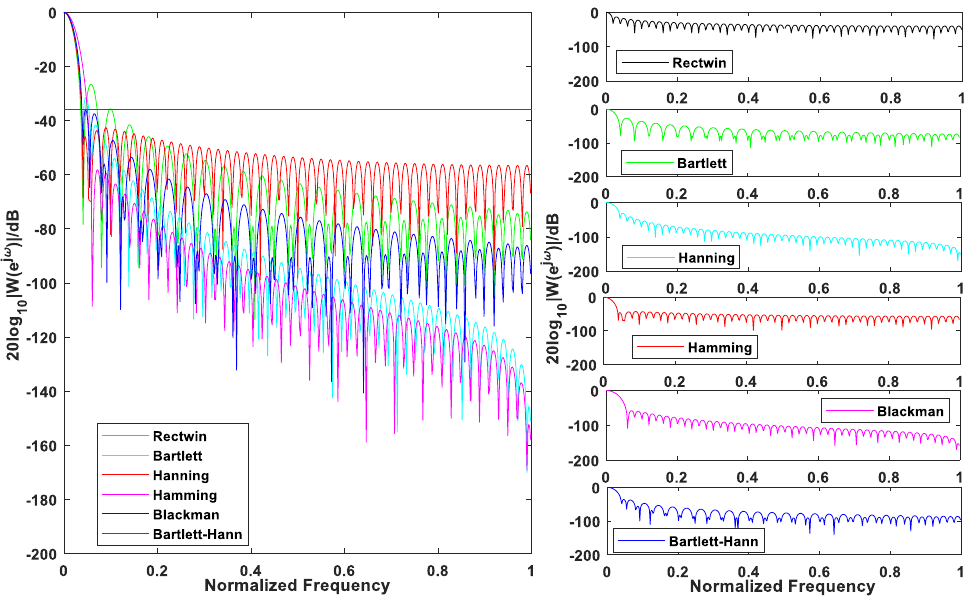
Figure-2. Bartlett–Hann window spectrum comparison with several common windows. Figure 2. Bartlett–Hann window spectrum comparison with several common